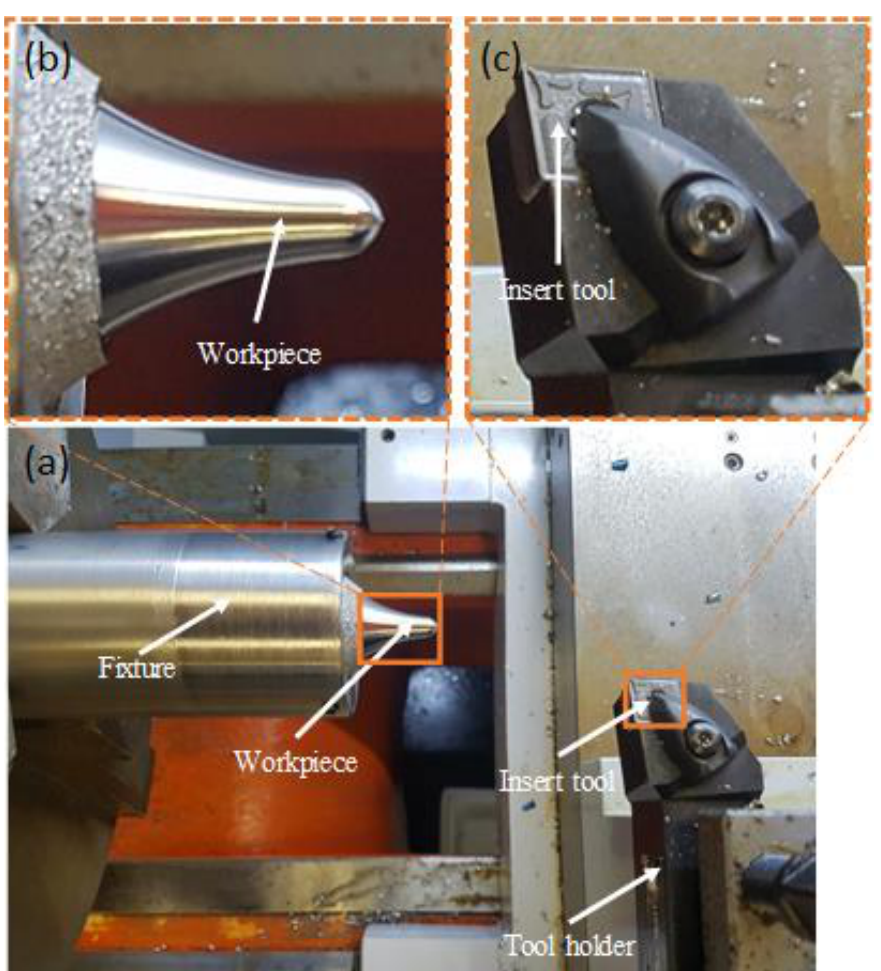
Figure 3. Dry machining process setup for non-prismatic component produced by EBM: ( a ) turning process setup; ( b ) enlarged view of a machined part; and ( c ) enlarged view of insert tool.